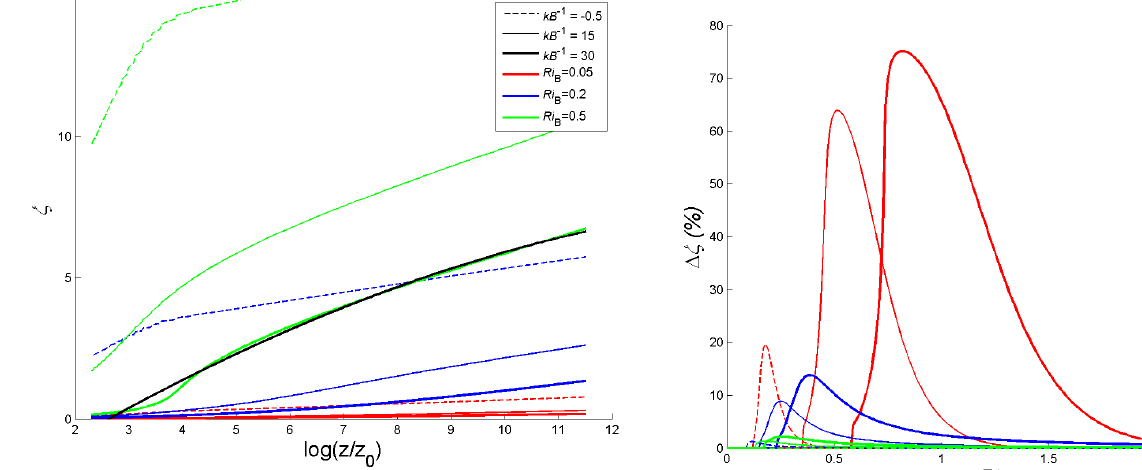
Fig. 4. Relative error after five steps of iteration with CB05 equa- tions under certain z 0 and z 0 h